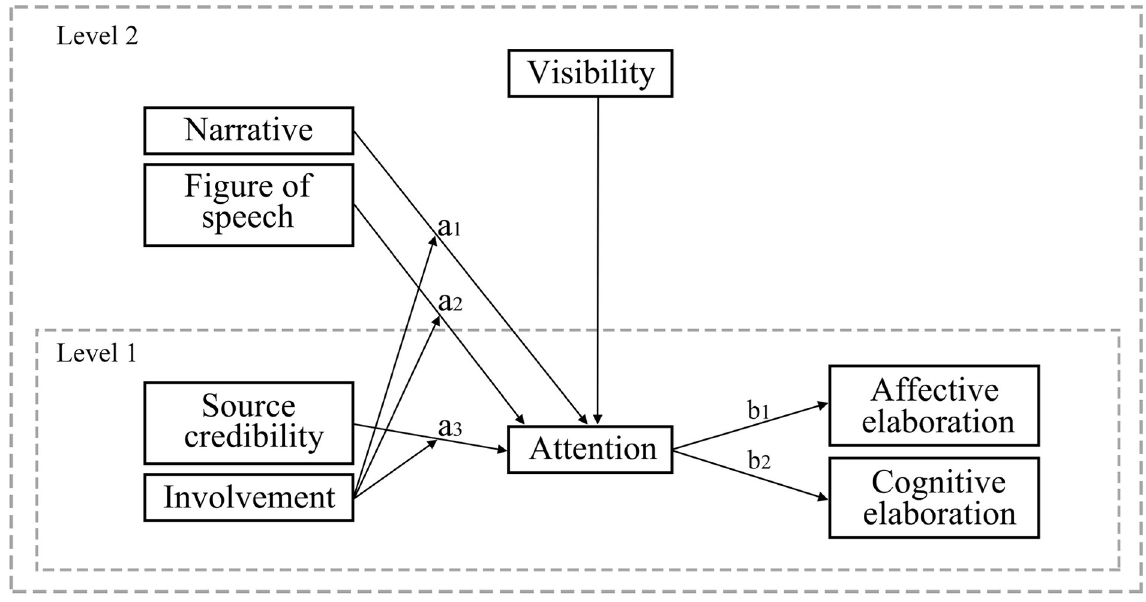
Fig 1. Multilevel moderated mediation